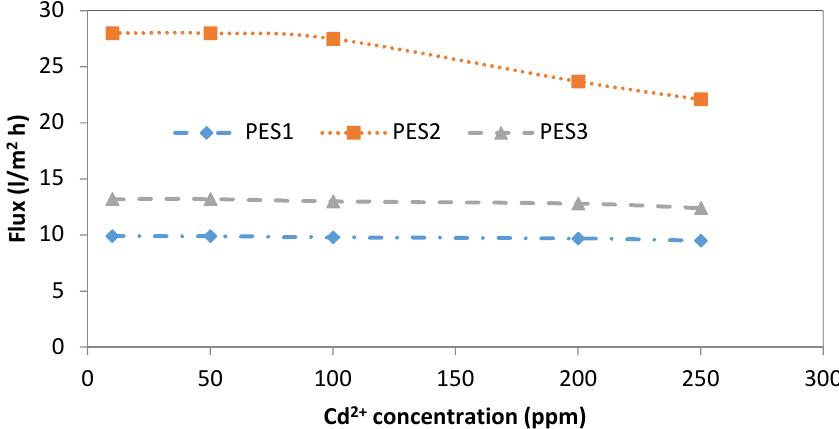
Figure 8. Effect of Cd 2+ initial concentration on permeate flux of PES1, PES2, and PES3 membranes (experimental conditions: pH = 6 ± 0.2, transmembrane pressure of 1 bar).